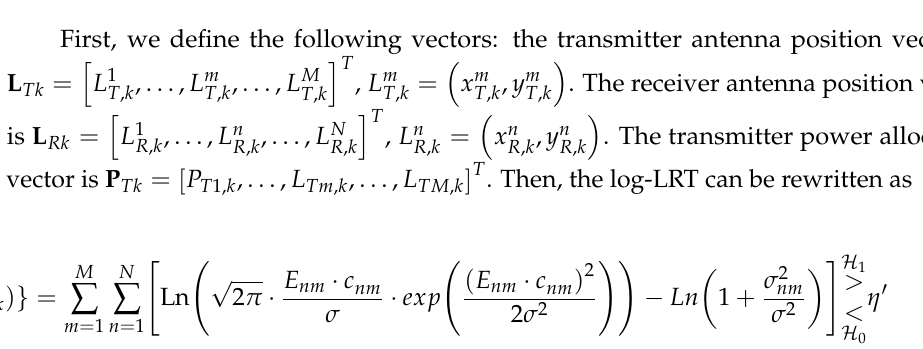
Figure 2. Illustration of the proposed JAPPA method.